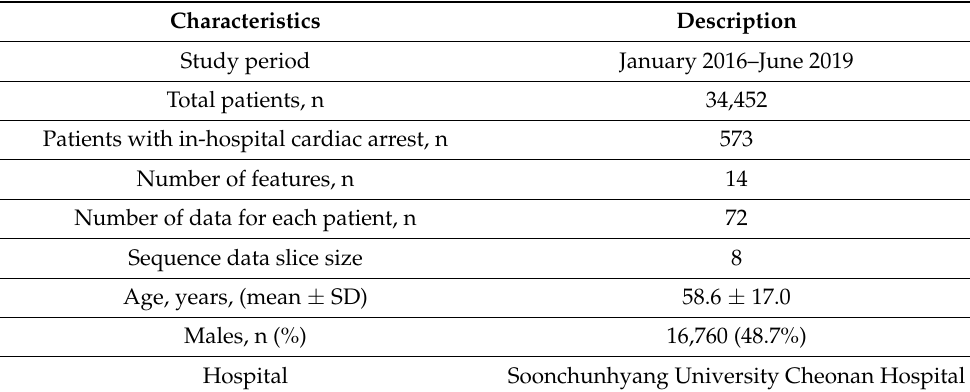
Table 1. Characteristics of the study population.